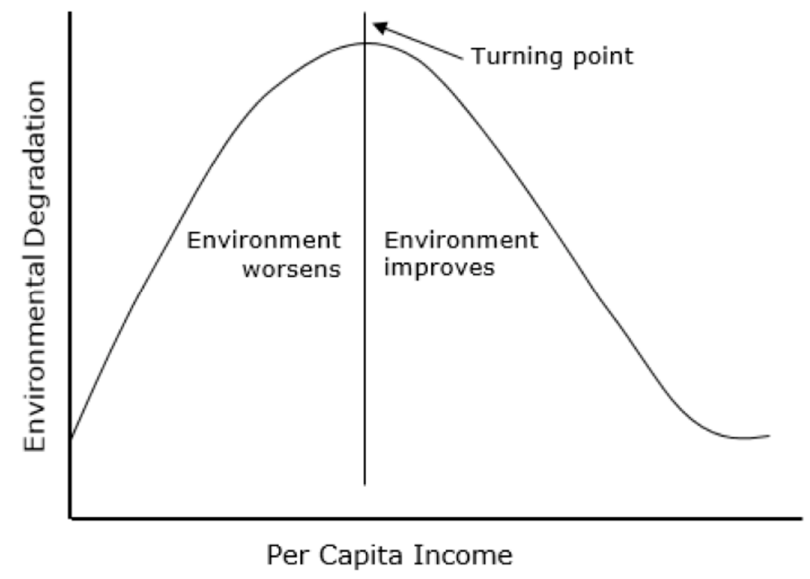
Figure 1 . Environmental Kuznets curve. Figure 1. Environmental Kuznets